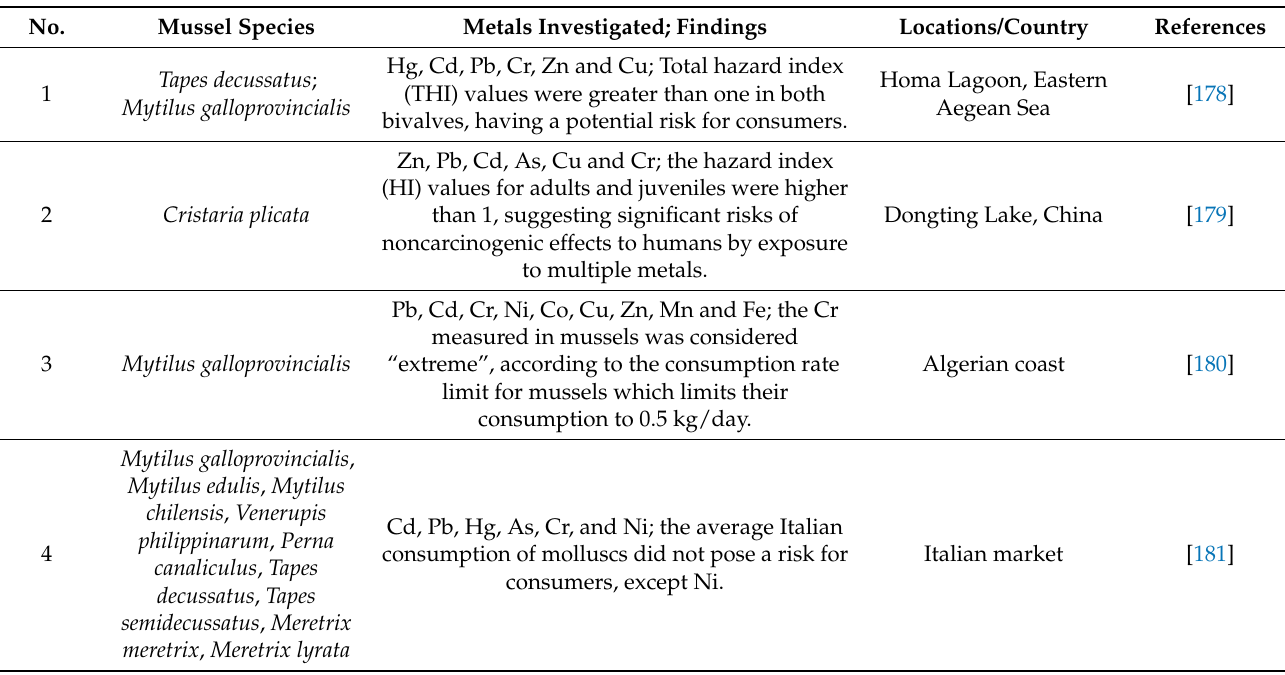
Table 4. A review on the human health risk assessments of heavy metals in bivalves from some of the available literature. No. Mussel Species Metals Investigated; Findings